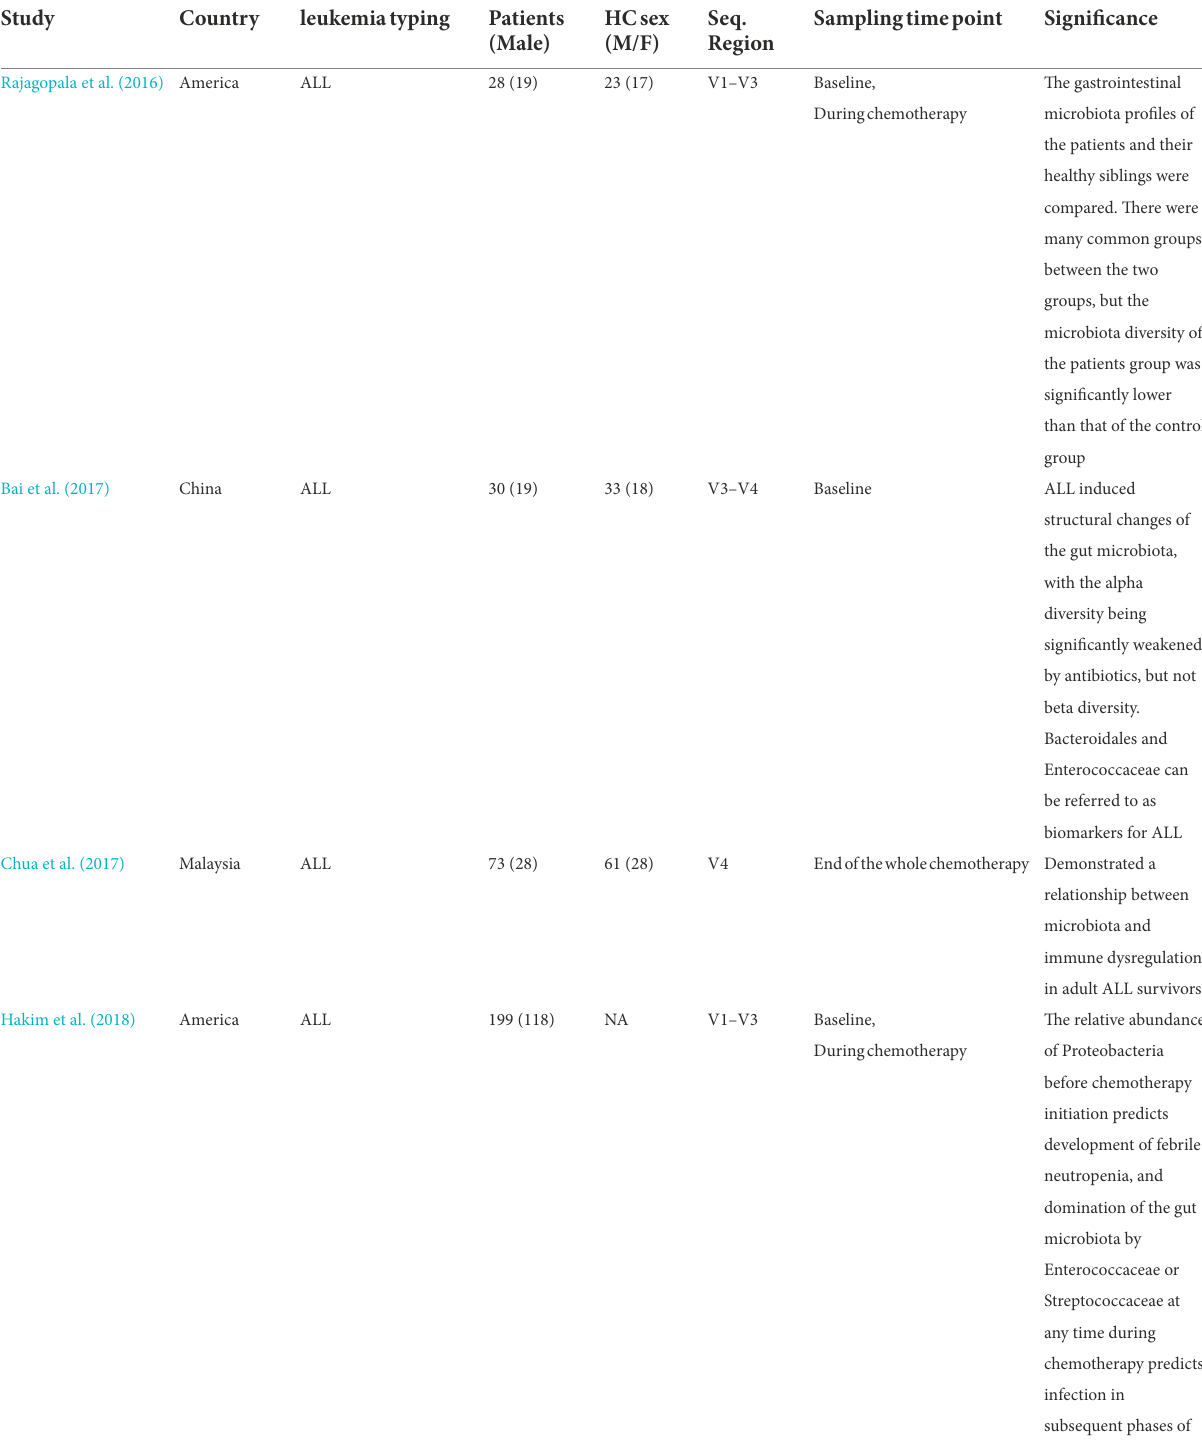
TABLE 1 Microbiota studies in Acute